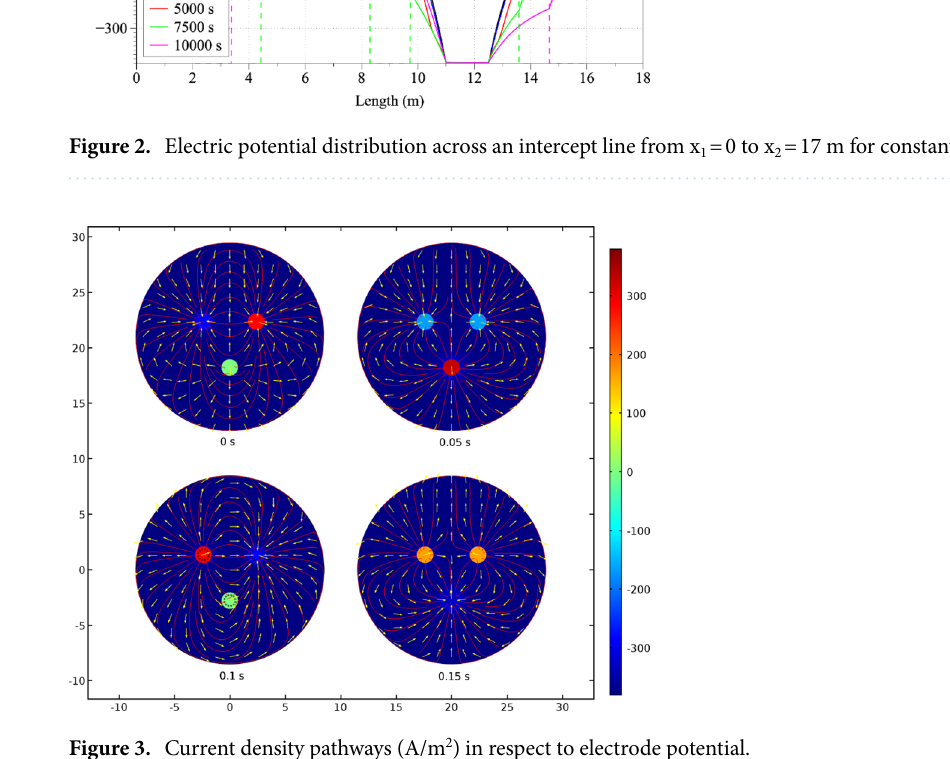
Figure 3. Current density pathways (A/m 2 ) in respect to electrode